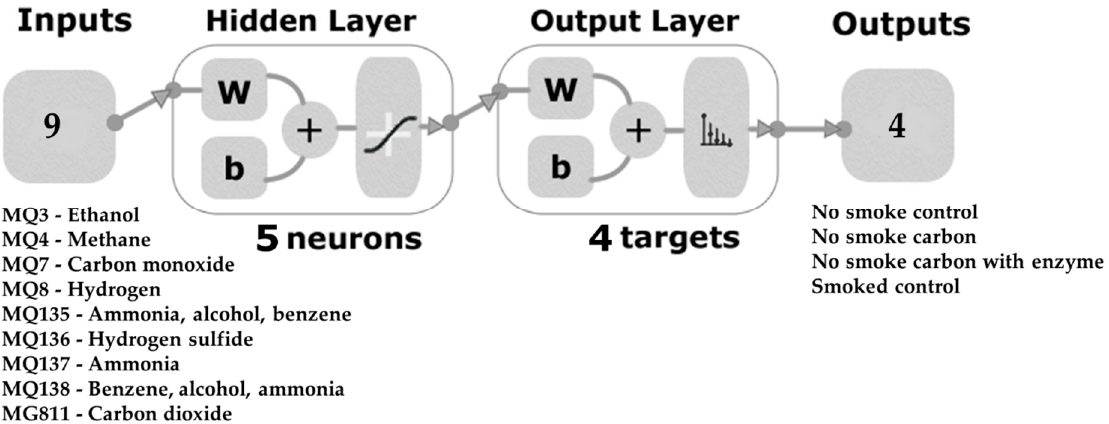
Figure 1. Two-layer feed-forward network with five hidden neurons and sigmoid function to classify wine samples according to the type of smoke taint amelioration treatment applied and smoke taint status (smoked or unsmoked). Abbreviations: w: weights; b: bias.